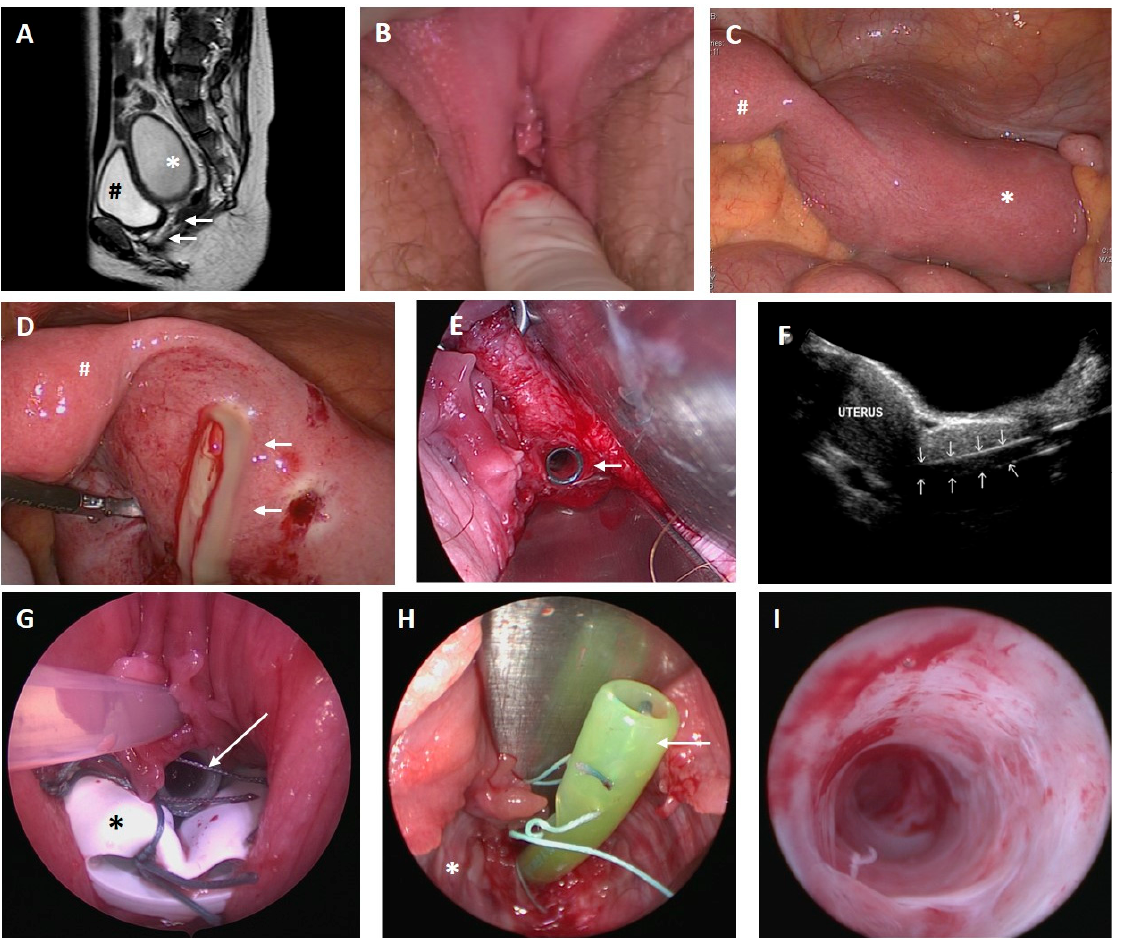
Figure 2. Case 2. ( A ) Magnetic resonance imaging from the pelvis; * hematometra (6.5 × 6.1 × 8.6 cm); arrows show vaginal atresia; # bladder. ( B ) Introitus vagina with vaginal atresia. ( C ) Laparoscopic view of an enlarged right-sided uterus unicornis (*) and a rudimentary left uteral horn (#). ( D ) Discharge of pus after transfundal incision (arrows); # left rudimentary uteral horn. ( E ) Arrow shows intracervical Fehling tube after vaginal and cervical reconstruction. ( F ) Transabdominal sonography; the uterus is displayed with normal endometrium on the left side; the right side of the picture, the intracervical Fehling tube is indicated by small arrows. ( G ) Vaginal device (*) with intracervical Fehling tube (arrow). ( H ) Fehling tube within the uterovaginal anastomosis (arrow), completely epithelialized neovagina (*). ( I ): Latest hysteroscopy after relief of pyometra and cleavage of adhesions.